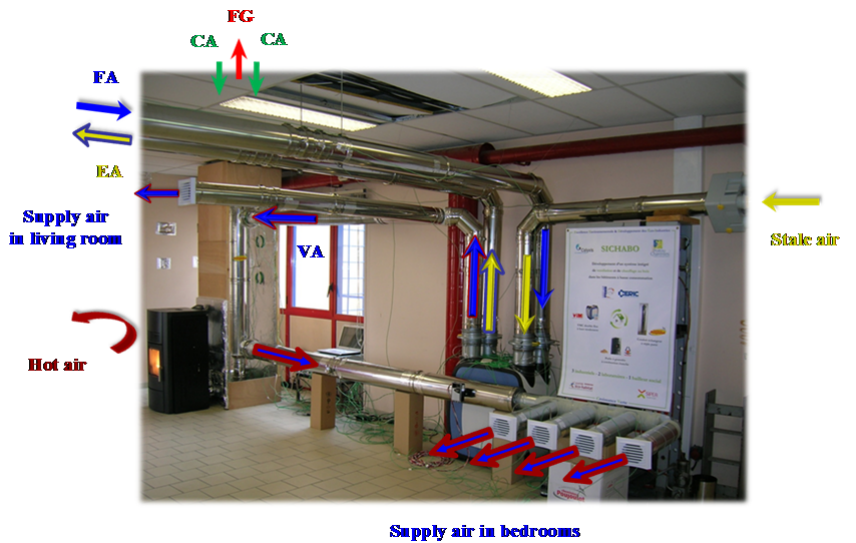
Figure 5. View of the experimental setup in